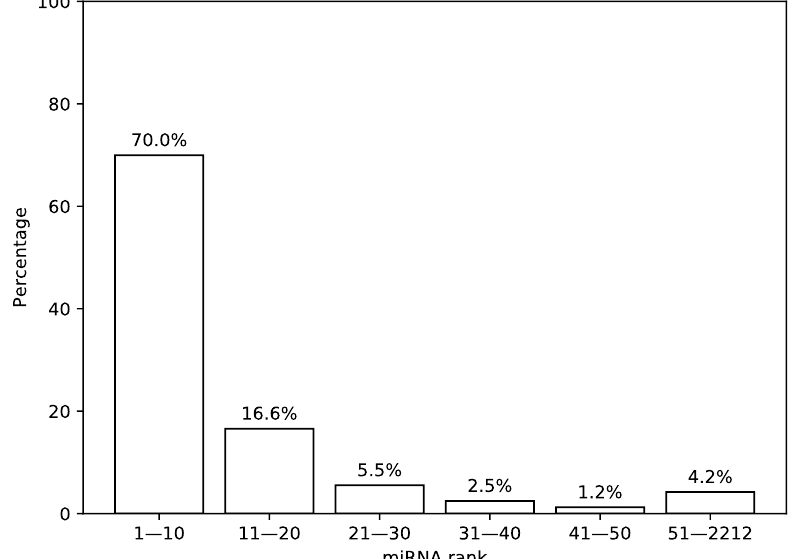
Figure 2. Distribution of expression values in The Cancer Genome Atlas (TCGA) miRNA-seq data. In this figure, a percentage of total miRNA expression covered by the first n most highly expressed miRNAs according to the TCGA miRNA-seq data are